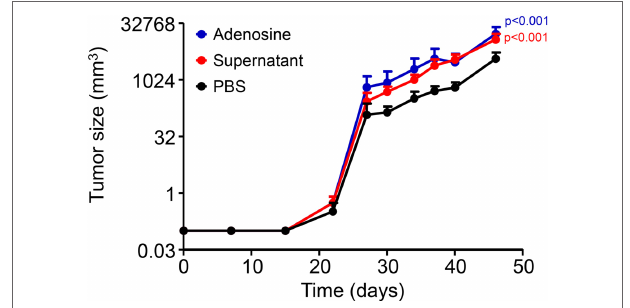
FigUre 5 | stimulation of proliferation in vivo . The presence of adenosine or supernatant of irradiated cells at the site of implantation of 50,000 B16F10 cells caused development of larger subcutaneous tumors in C57Bl/6 mice ( n = 6 per